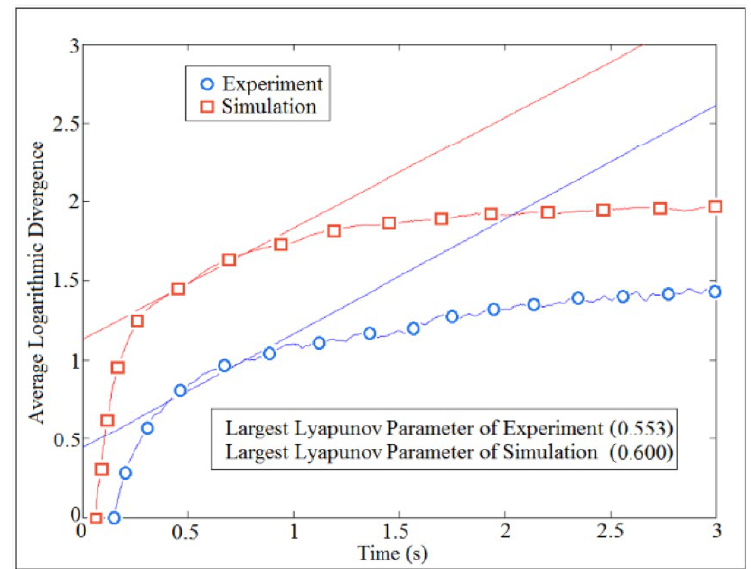
Figure 12. Largest Lyapunov exponent against time for plate with one stiffener.